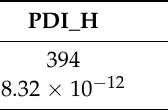
Table 3. R ct and D Li of PDI_AAs